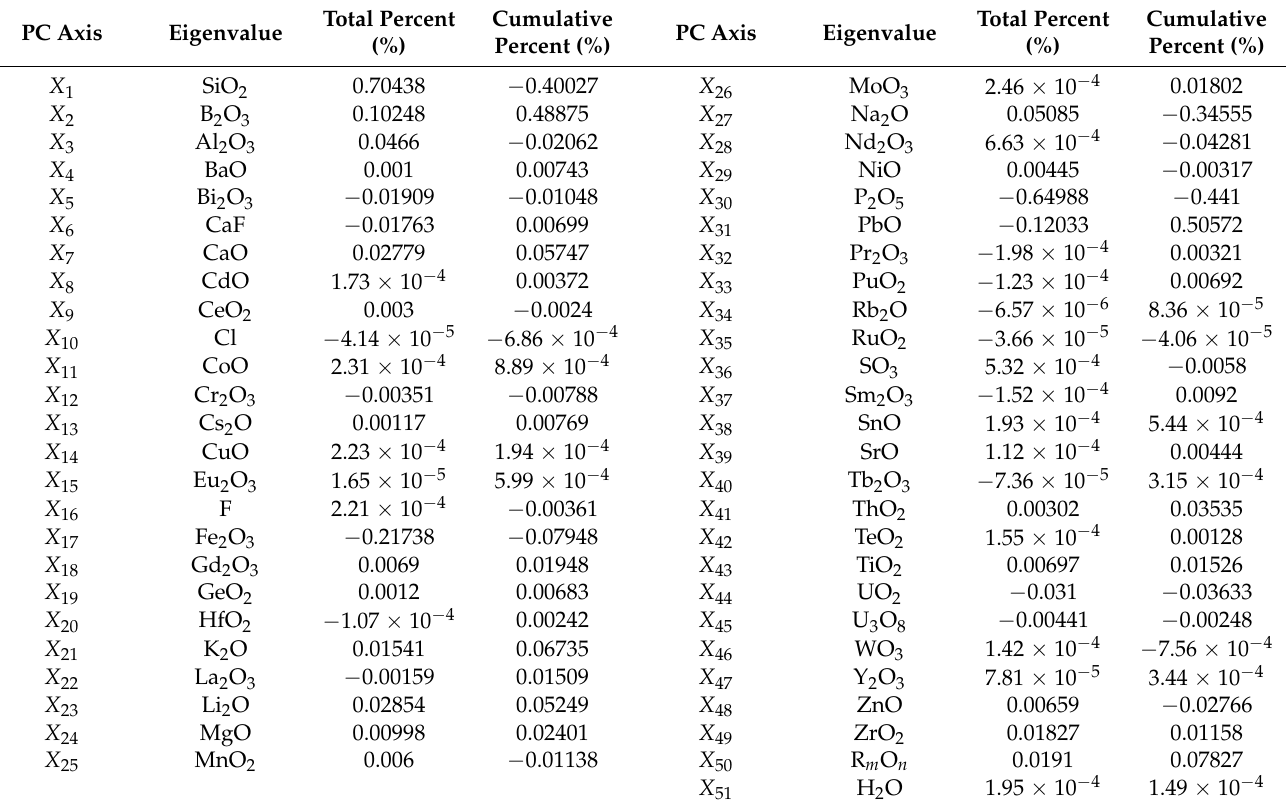
Table 3. Eigenvector values of first and second main components considering the covariance and correlation matrices,